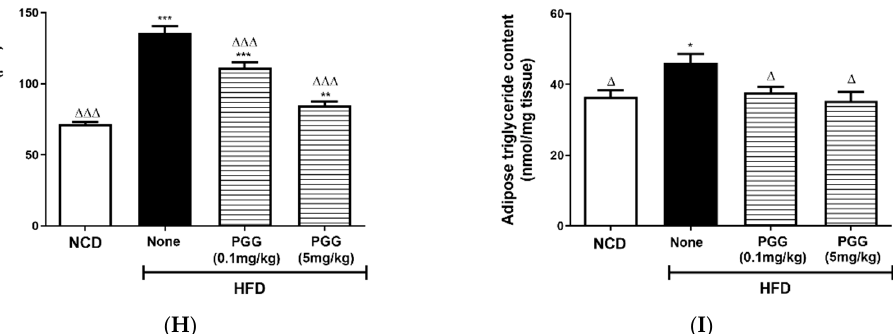
Figure 4. Effect of 12 weeks of β -PGG supplementation on body weight, serum lipids and adipose tissue in DIO mice. ( A ) The weekly body weight of DIO mice treated with PGG ( n = 6), ( B ) images of dissected mice at the end of the PGG treatment, ( C ) average weekly food intake ( n = 6), ( D ) colon length, ( E ) serum free fatty acids, ( F ) serum triglyceride, ( G ) images of haematoxylin–eosin-stained adipose tissue, ( H ) diameter of adipocyte cells ( n > 50 per group), and ( I ) adipose tissue TG content. Data are shown as mean ± SEM ( n = 4). * p < 0.005, ** p < 0.01, and *** p < 0.001 compared with control diet (NCD) group. ∆ p < 0.05 group and ∆∆∆ p < 0.001 compared with HFD (none) group.